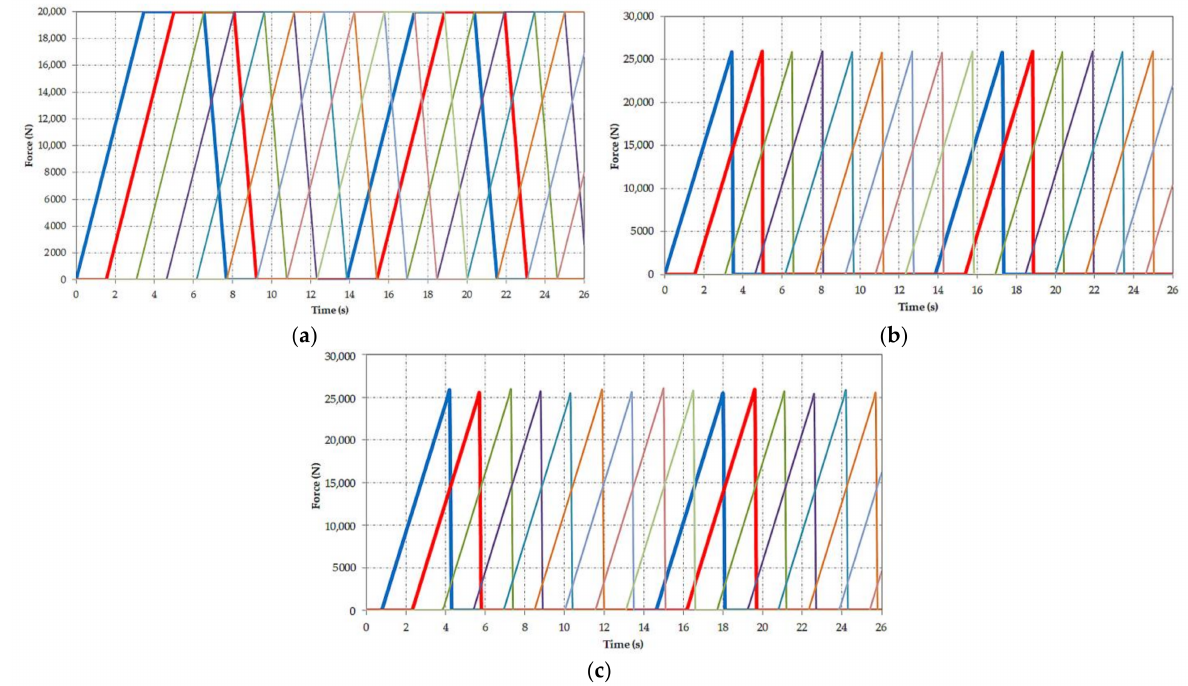
Figure 5. Time variation of ( a ) the transport and inertia force for all cutting and loading (CL) buckets; ( b ) the cutting force for all cutting and loading (CL) buckets; ( c ) the cutting force for all cutting (C)